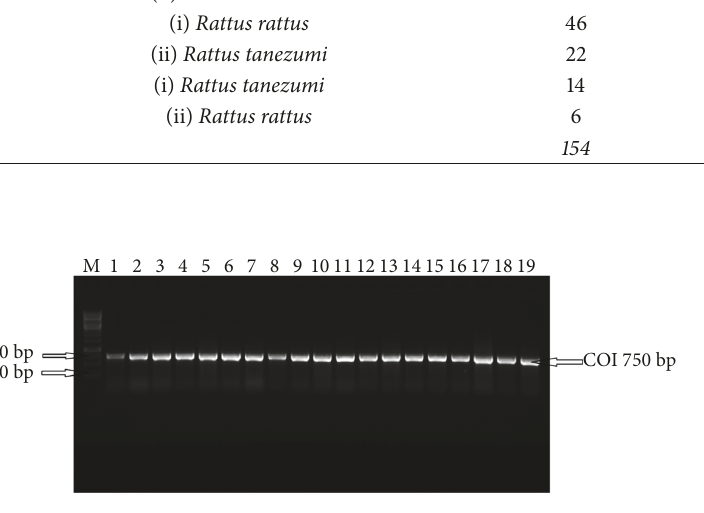
Figure 2: PCR amplification of COI gene. Lane M: molecular weight marker (1kb). Lanes 1-19 are COI gene fragments from DNA extracted from